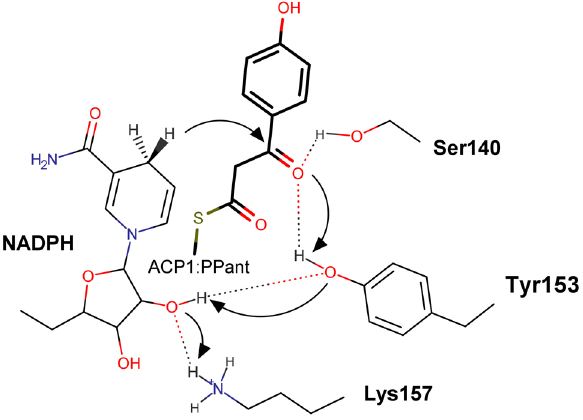
Figure 8. Proposed reaction scheme of ApeQ. Residues involved in the binding and catalysis of β-keto group reduction are presented. The visible moiety of the substrate is rendered as thicker bonds. Hydride transfer is depicted by